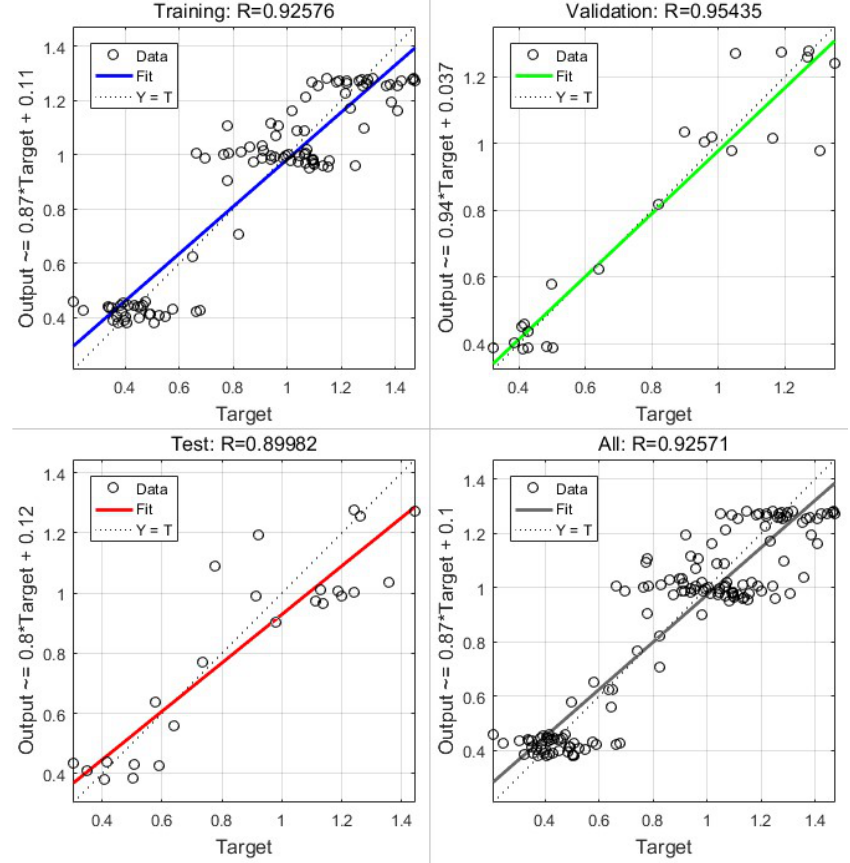
Figure 6. ANN-fitted delamination response functions at the entry ( top ) and exit ( bottom ) of a hole drilled with double-point angle drill is presented as 3D surfaces ( left ) and contour plots ( right ).